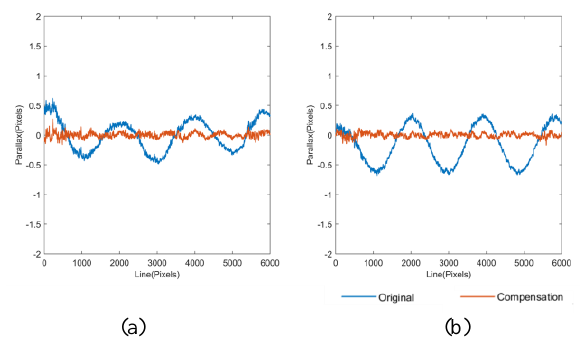
Figure 8 . CCD2 parallax of B1and B2 before and after jitter compensation ((a) is the along-track direction parallax (b) is the cross-track direction